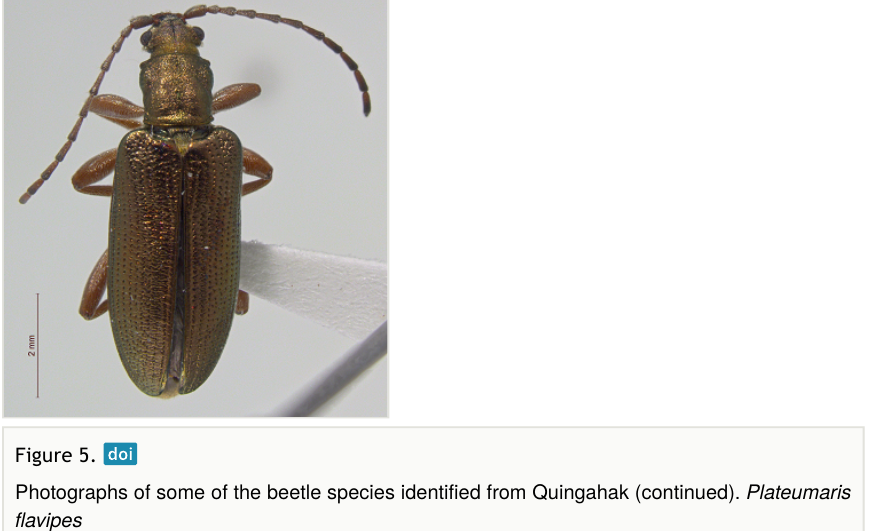
Three dytiscid specimens were identi fi ed as Ilybius angustior (Gyllenhal) complex.